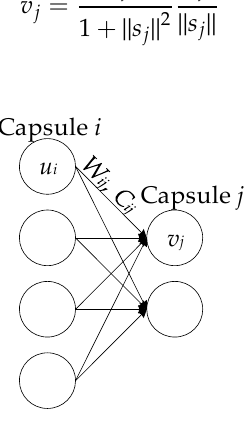
Figure 1. Calculation chart of Capsule.